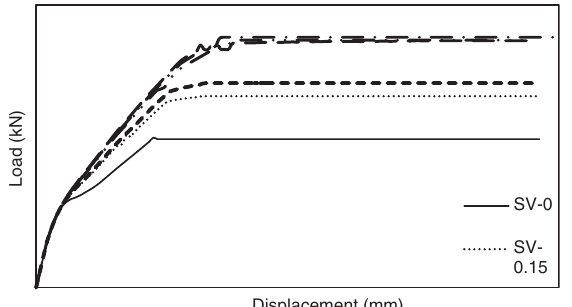
Fig. 7. Load – de fl ection curves series SV